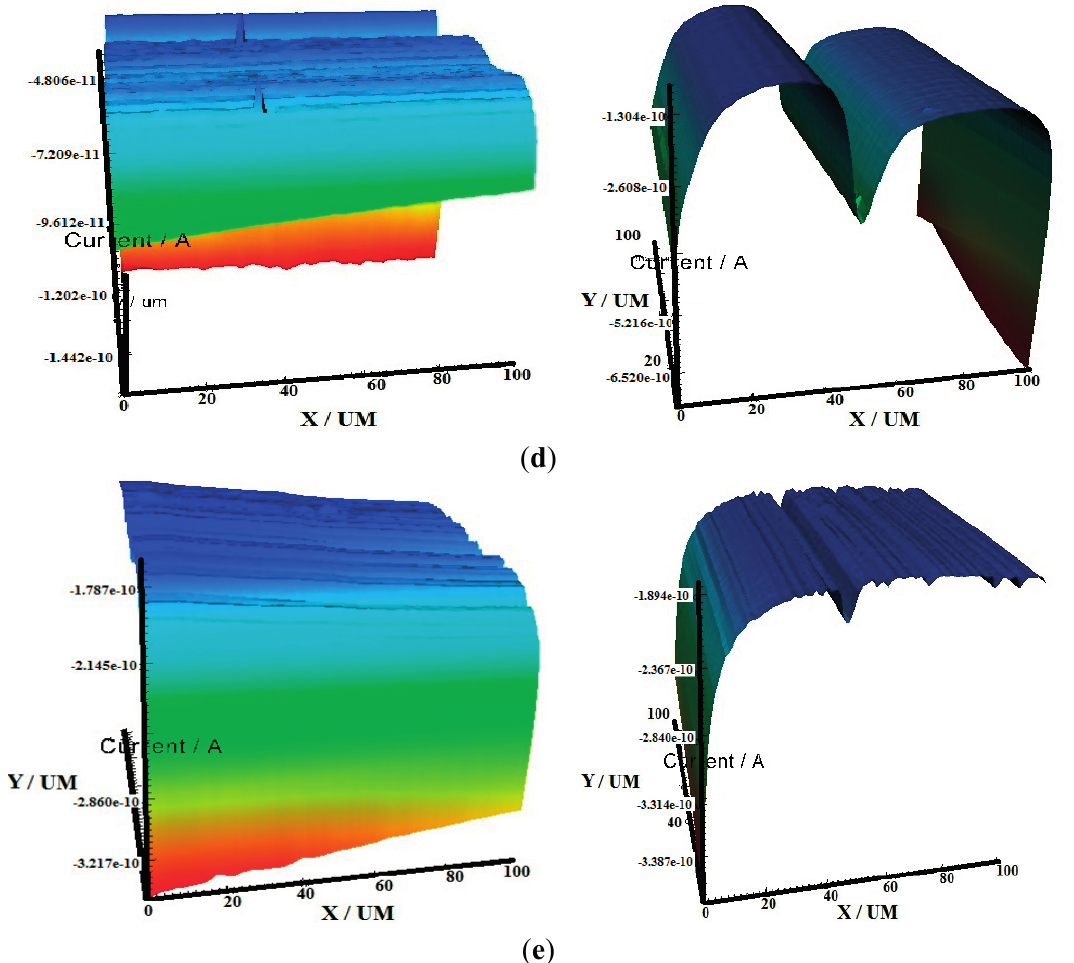
Figure 7. 3D-SECM images ( left : x-axis; right : y-axis) of N80 steel in 3.5% NaCl saturated with CO 2 ( a ) without the inhibitors; and with 200 ppm ( b ) HPTB; ( c ) T4PP; ( d ) THP and ( e )